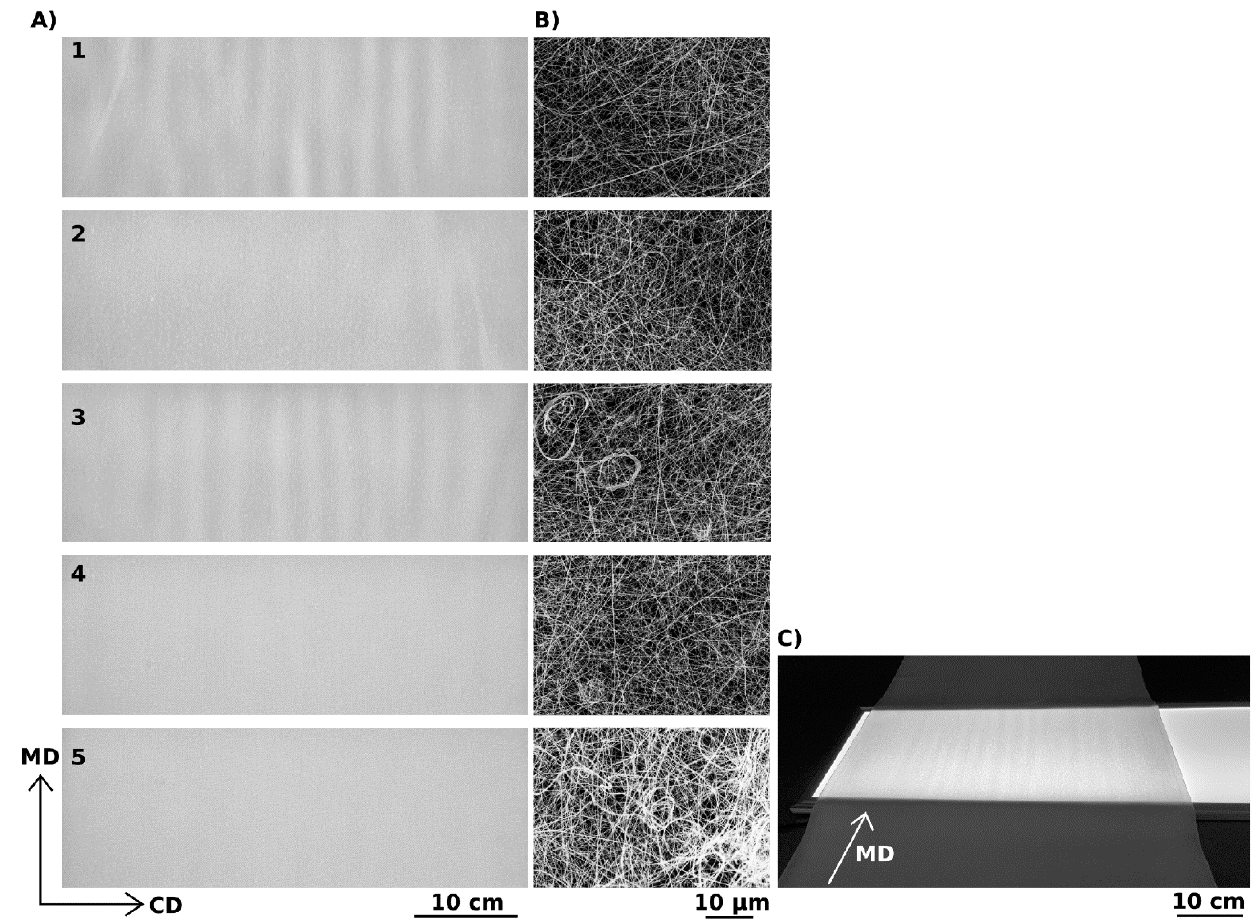
Figure 4. Images of nanofibrous layers photographed against light ( A ) and corresponding SEM images ( B ). An example of how the images were recorded in backlight ( C ). Each layer was prepared using different process parameters, see Table 1. CD is cross direction and MD is machine direction.